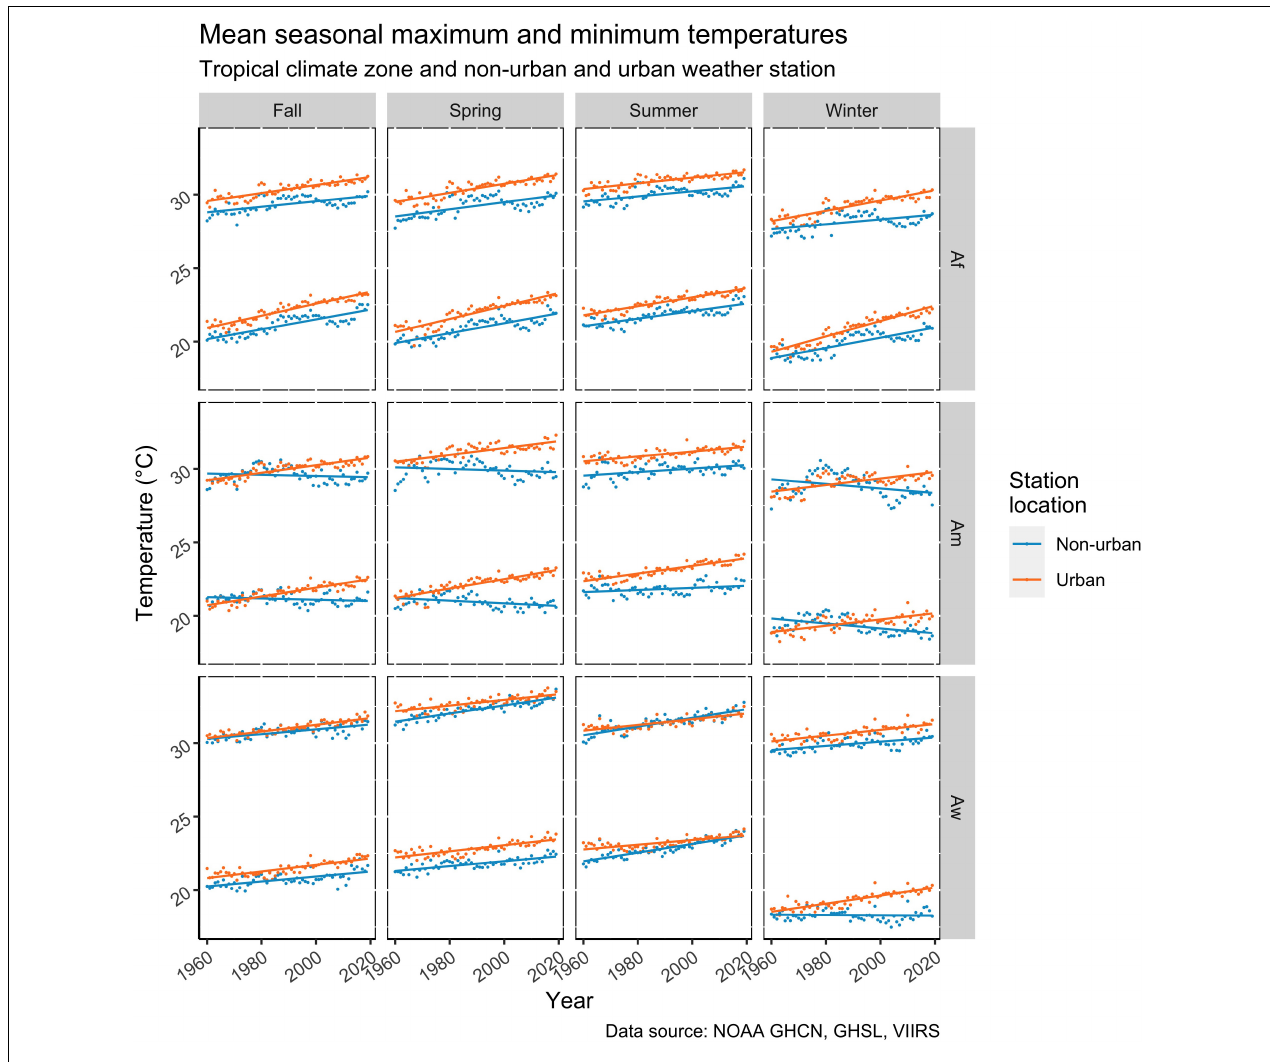
FIGURE 10 | Mean seasonal maximum and minimum temperatures for urban and non-urban areas by tropical zone. The higher points and curves on each mini-plot represent the maximum temperatures and the lower points and curves represent the minimum temperatures. Data source: NOAA,